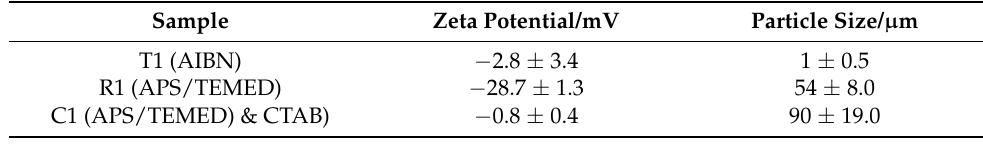
Table 1. Zeta potential data for polyNIPAm microspheres produced using thermal (T1) and redox (R1) initiators, and a redox initiator in the presence of CTAB surfactant (C1). Sample